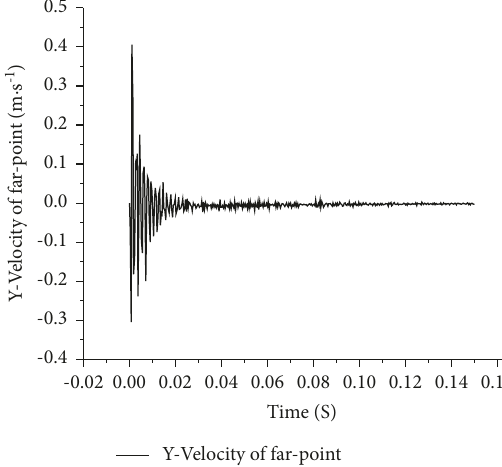
Figure 11: Y-vibration time course of near point at arch waist.